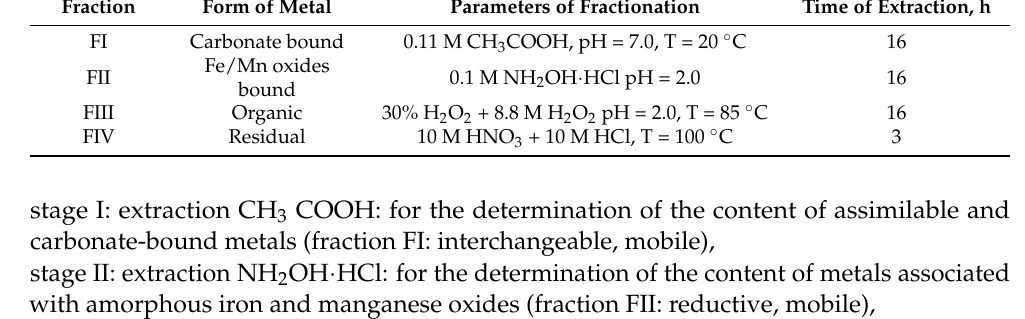
Table 2. Method of metal speciation of heavy metals in sewage sludge and soil [30,31]. Fraction Form of Metal Parameters of Fractionation Time of Extraction,